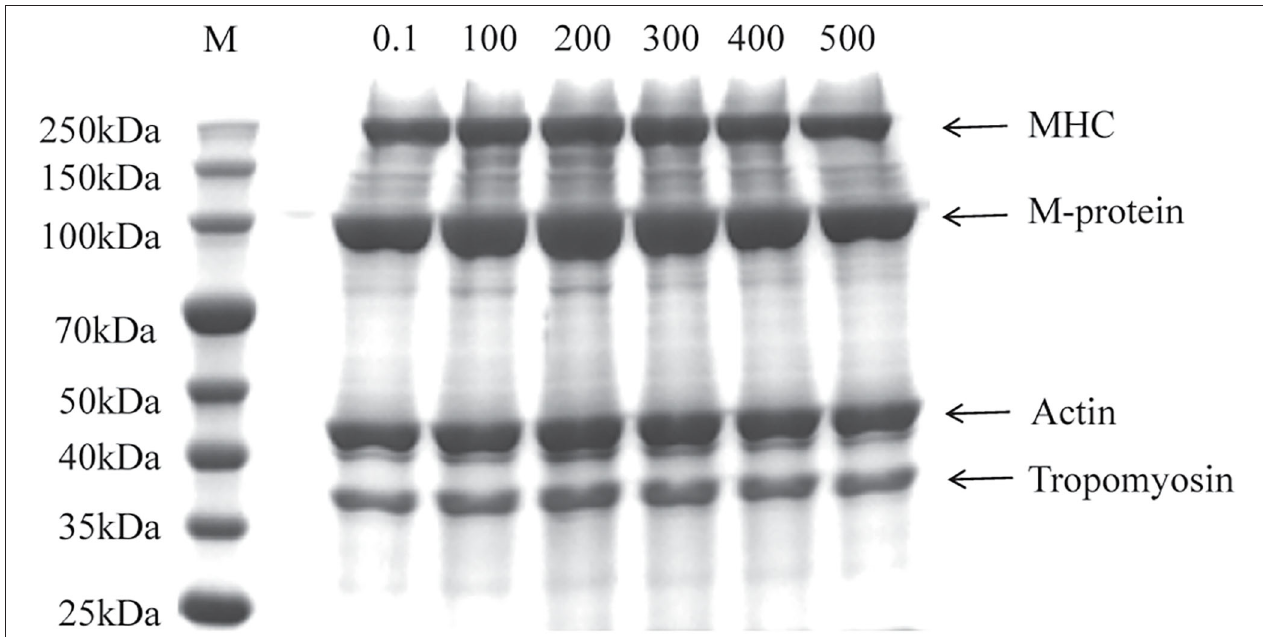
FIGURE 1 | Sodium dodecyl sulfate-polyacrylamide gel electrophoresis (SDS-PAGE) profile of myofibrillar protein (MP) from the scallop mantle at different pressures (Lane M: protein marker, MHC: myosin heavy